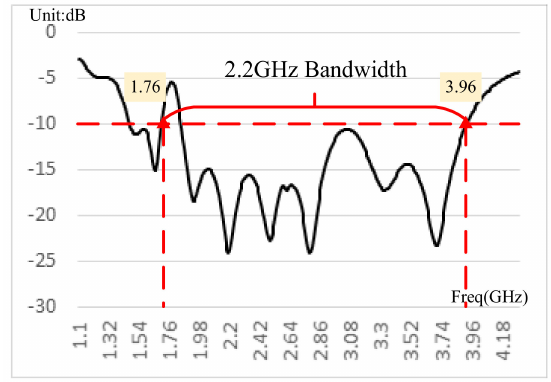
Figure 11. Improved transmitting antenna